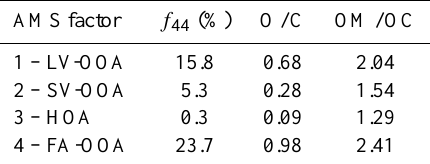
Table 4. OM/OC ratios determined for each PMF-factor by apply- ing the general relationships found by Aiken et al. (2008) relating the fractional abundance of m / z 44 to the O/C ratio and thereby to the OM/OC